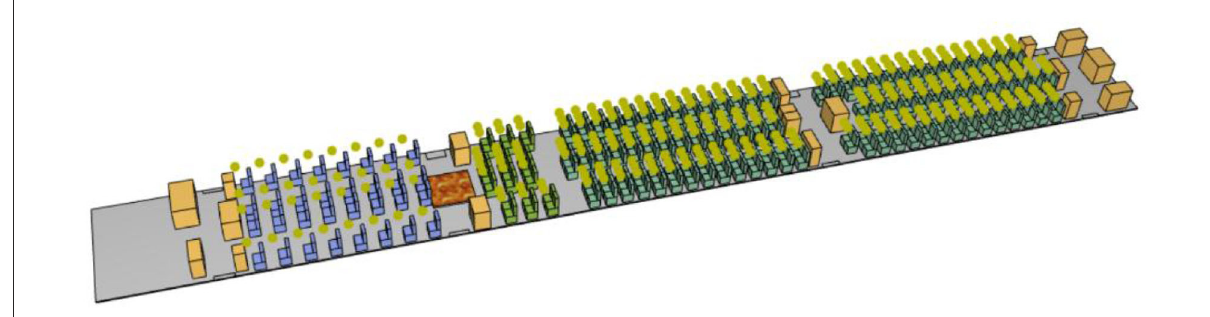
FIGURE6 Location diagram of 312 observation points of the cabin